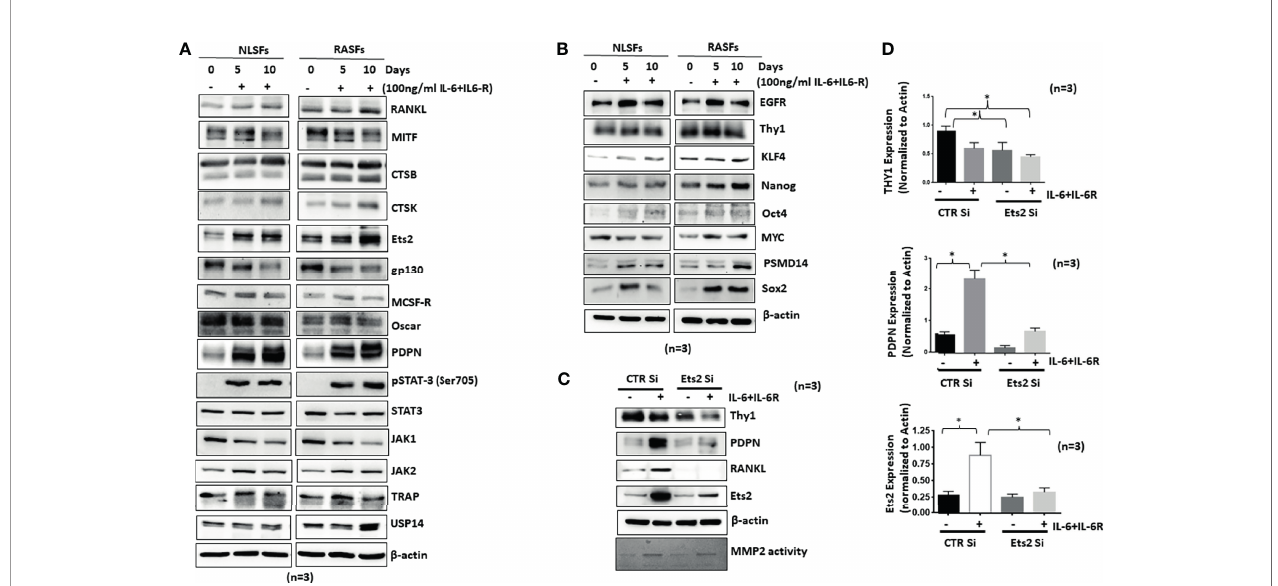
FIGURE 6 | IL-6+IL-6R trans-signaling activates both NLSFs and RASFs to an aggressive and invasive phenotype mediated by Ets2. (A) NLSFs and RASFs were differentiated in the presence of IL-6+IL-6R for 5 and 10 days followed by preparation of whole cell extracts that were then probed for osteoclast-speci fi c markers. IL-6 trans-signaling was activated in both NLSFs and RASFs that led to the increased expression of Ets2 which in turn increased the expression of RANKL, CTSK, CTSB, and PDPN. (B) IL-6+IL-6R stimulation upregulated the expression of differentiation marker proteins Sox2, Oct4, KLF4, and Nanog higher in RASFs as compared with NLSFs. (C) IL-6+IL-6R-induced heterogeneity markers in RASFs, Thy1, and PDPN were downregulated in the absence of Ets2. (D) Quantitation of Thy1, PDPN, and Ets2 in 12-day differentiated RASFs con fi rms more then 80% knockdown of Ets2 as well as signi fi cant reduction in PDPN and Thy1 expression. *p <